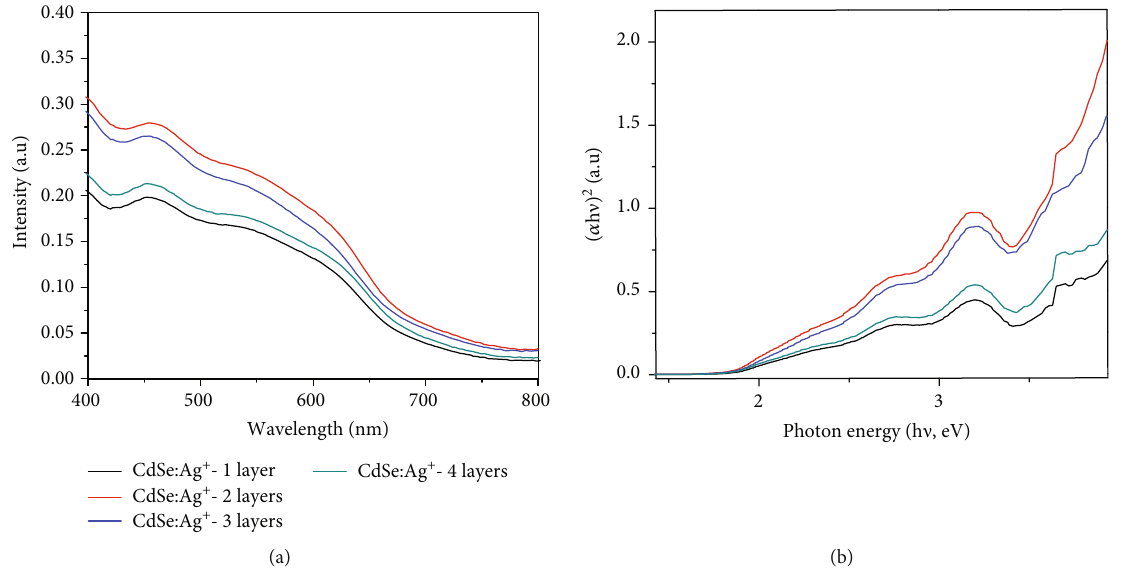
Figure 2: (a) UV-Vis spectra and (b) ( α h ν ) 2 vs. (h ν ) curves of TiO